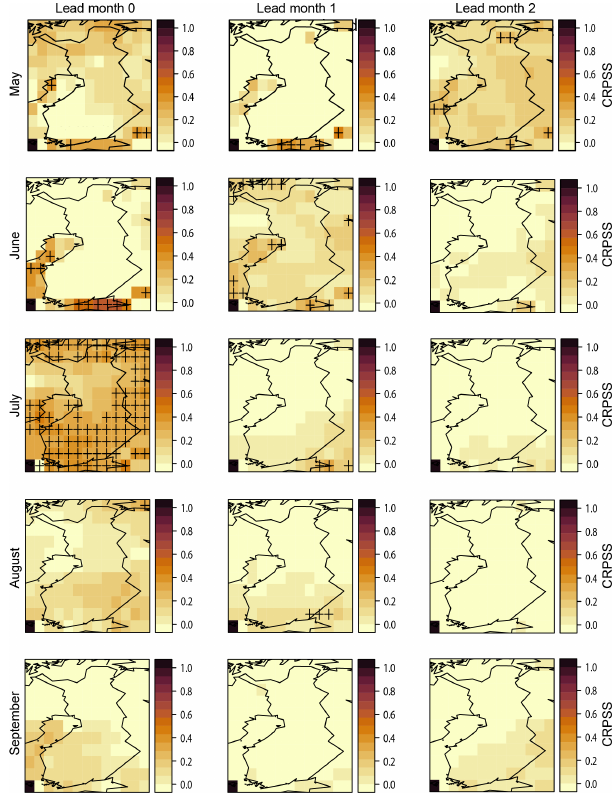
Figure 2. Maps of CRPSS for bias-corrected temperature (applying the EQM method) for May–September with lead months 0, 1 and 2. Statistically significant grid points are marked with